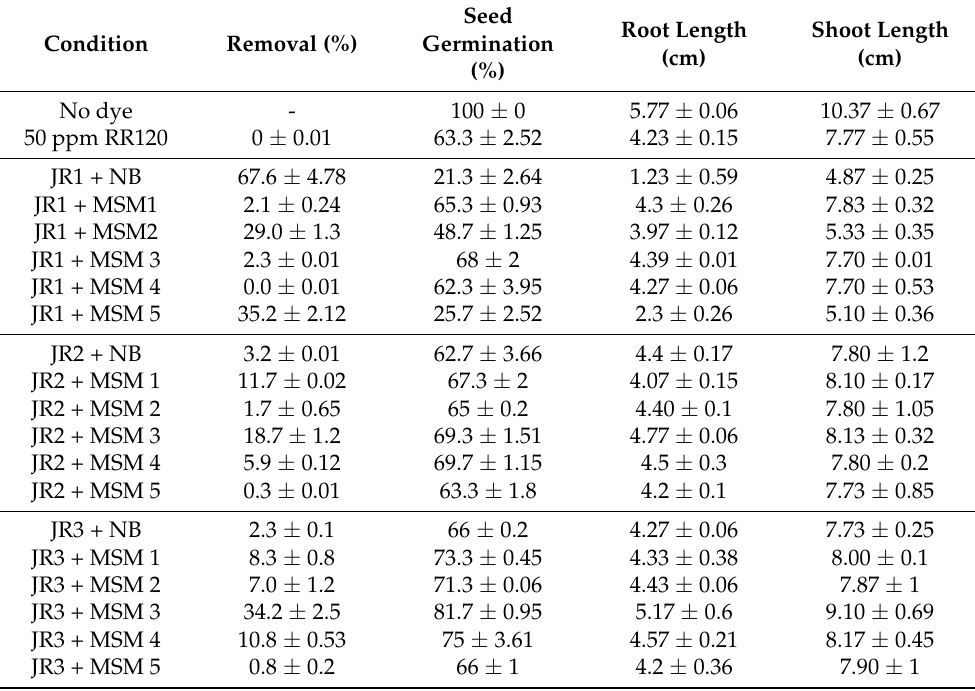
Table 7. Phytotoxicity study of Reactive Red 120 and its metabolite formed after decolourisation values are the mean of the germinated seeds of the three experiments, SD ( ± ), standard deviation.